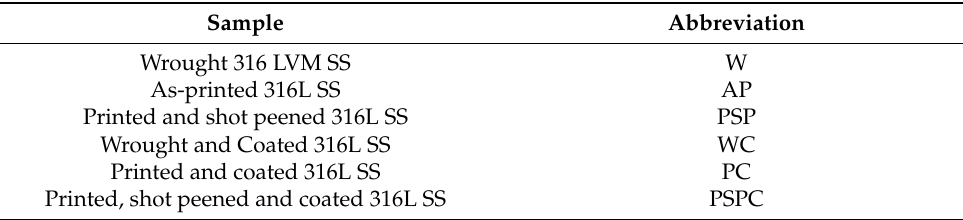
Table 3. Abbreviations for each sample